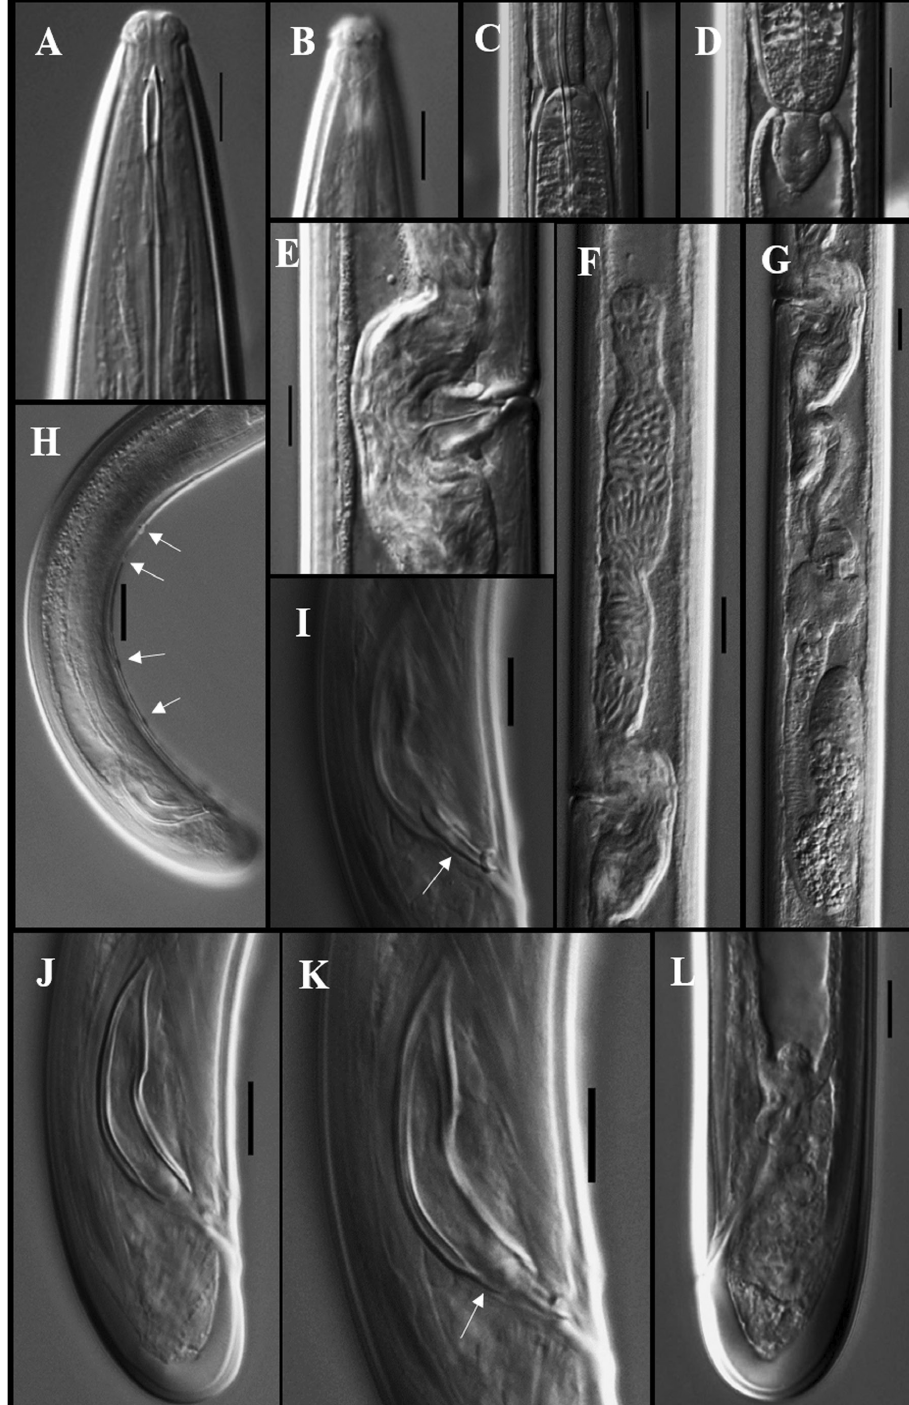
Fig. 14. Axonchium tropicum sp. nov. (LM photographs). A . Paratype 2, ♀ (slide 2). B – G , L . Holotype, ♀ (AMU/ZD/ Axonchium tropicum sp. nov. /1). H – K . Paratype 1, ♂ (slide 2). A . Anterior region. B . Anterior end showing amphid. C . Junction between two parts of pharynx. D . Cardia. E . Vulva and vagina. F – G . Genital branches. H . Ventromedian supplements. I . Lateral guiding pieces. J . Male posterior region and spicule. K . Spicule with arrow indicating its distal end. L . Female posterior region. Scale bars: A–E, I–L =10 µm; F–H = 20